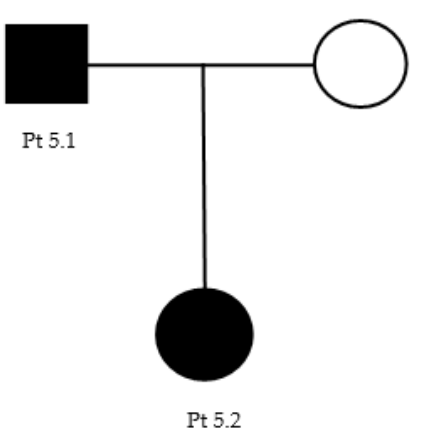
Figure A3. Family 5 pedigree.